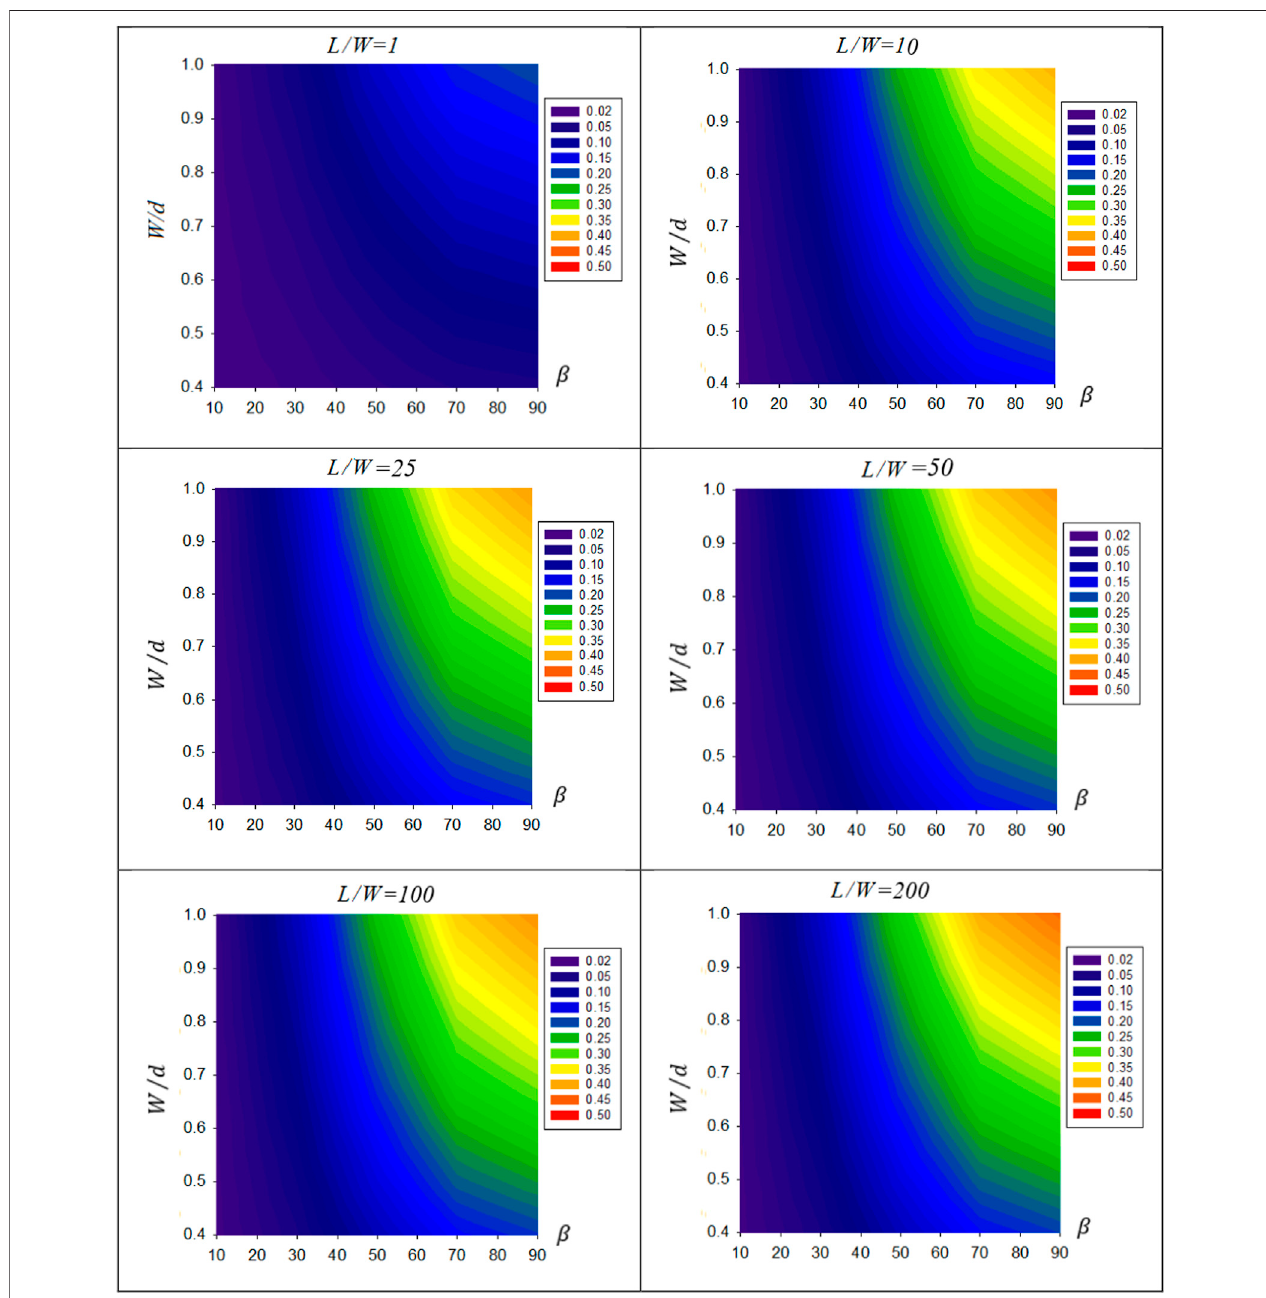
FIGURE 4 | Contour representation of F A